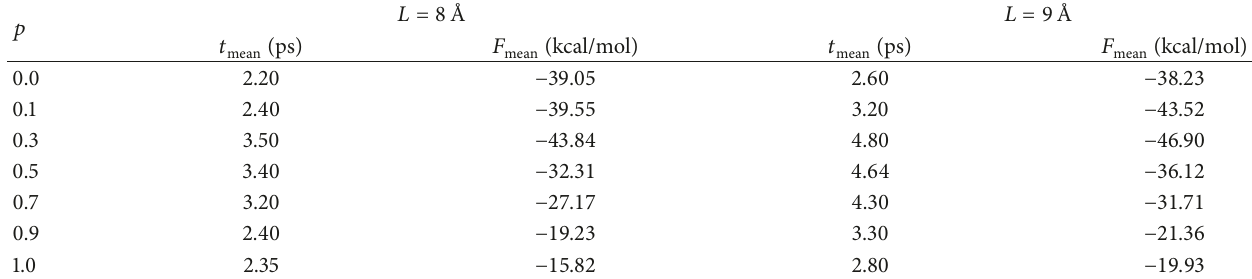
Table 2: The mean value of residence time 𝑡 mean and the mean energy 𝐹 mean for linear molecules with atomic distribution type (A), 𝜎 1 = 3.2 ˚A,